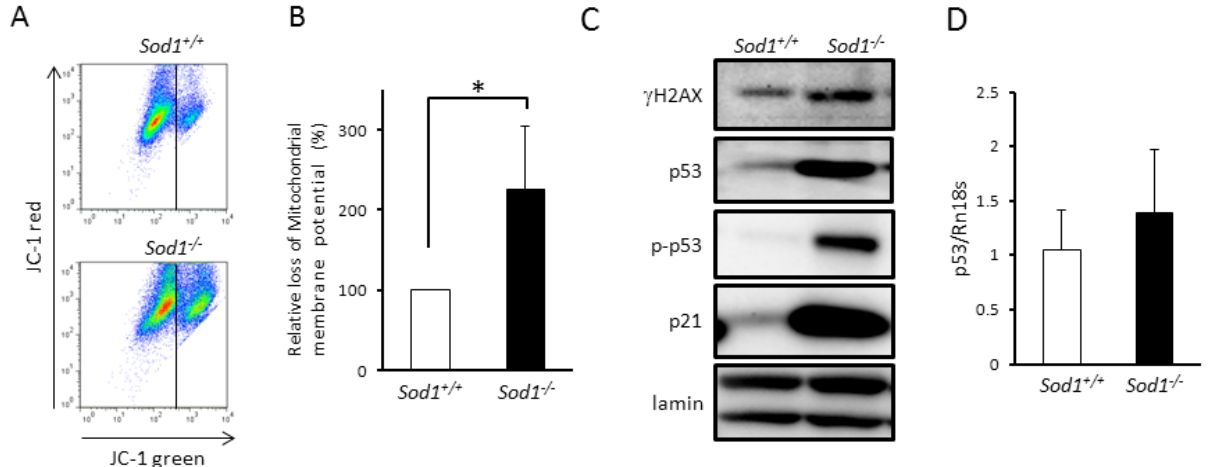
Figure 3. Sod1 loss induces mitochondrial dysfunction in fibroblasts. ( A ) The loss of mitochondrial membrane potential ( ΔΨ m) was measured by flow cytometry with JC-1; ( B ) The relative percentage of mitochondria with low ΔΨ m in Sod1 − / − and Sod1 +/+ fibroblasts ( n = 4); ( C ) Western blotting of DNA damage response proteins such as p53, p53 phosphorylation at Ser 18 , γ H2AX and p21 in Sod1 − / − and Sod1 +/+ fibroblasts; ( D ) p53 mRNA expression was analyzed by quantitative PCR in Sod1 − / − and Sod1 +/+ fibroblasts ( n = 4). These data indicate the mean ± SD; * p <